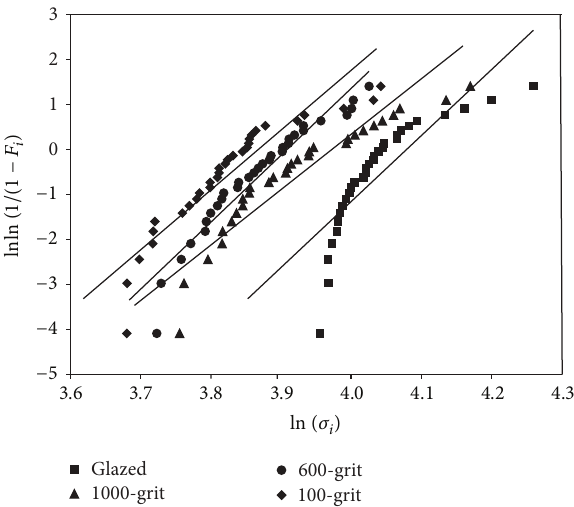
Figure 1: Three-point bending test results [6] of feldspathic body porcelain for four test groups.